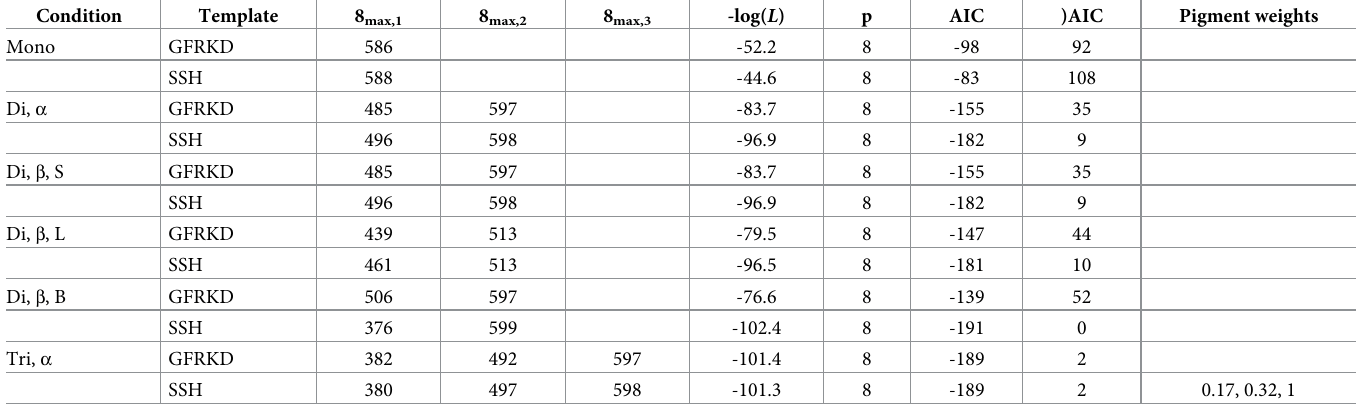
Table 5. The spectral sensitivity of European seabass fed a 5% taurine diet. Condition Pigment